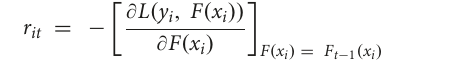
The framework of the proposed TrGB model is presented in Algorithm 1 . The algorithm is built on top of the original GBM structure with proper modifications to enable transfer